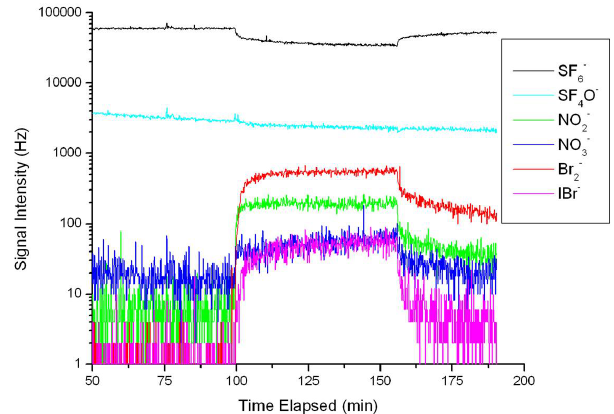
Fig. 7. Formation of gas phase halogens, primarily Br 2 (red line) upon exposure of frozen NaCl/NaBr/NaNO 3 mixtures to ultraviolet light at roughly 100min. Reprinted with permission from Abbatt et al. (2010). Copyright 2010 American Chemical